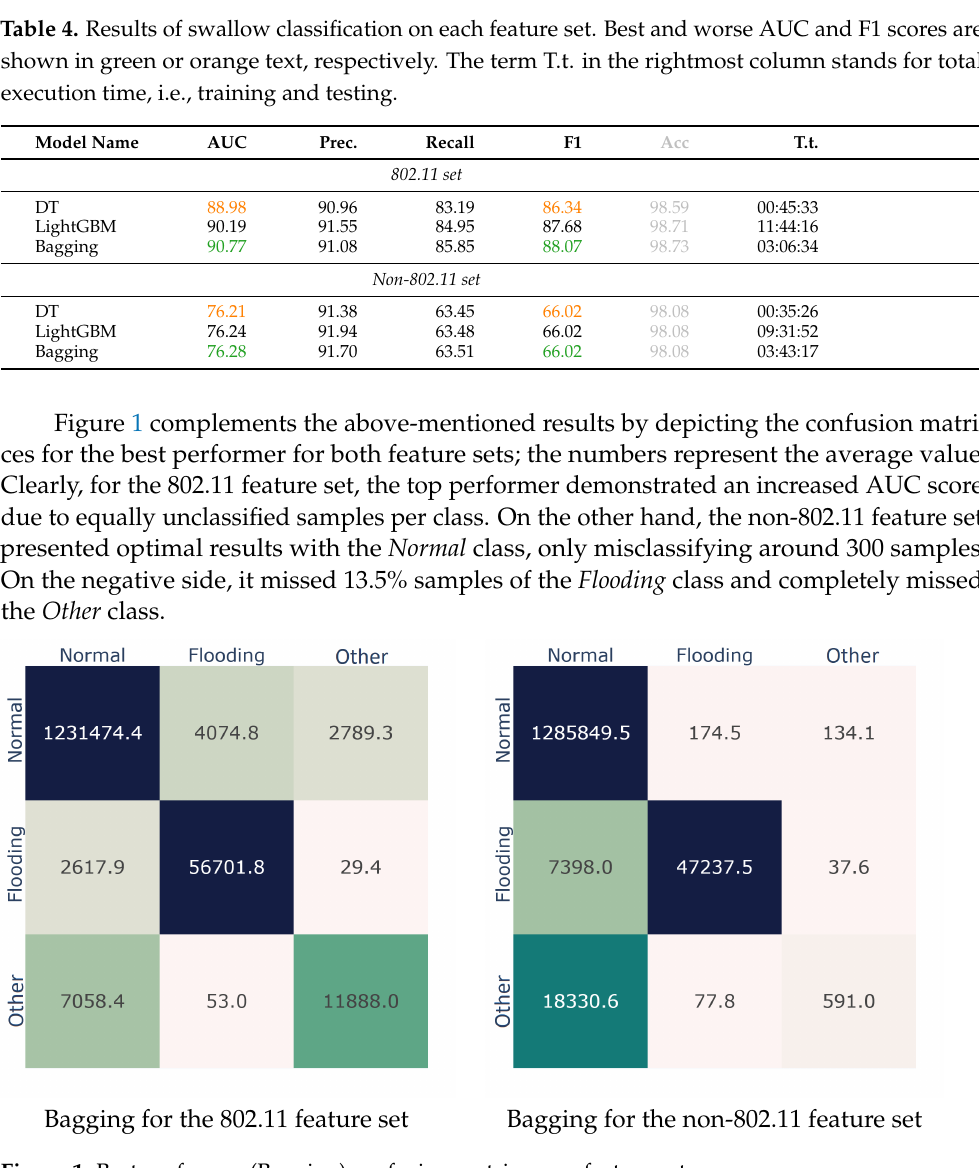
Figure 1. Best performer (Bagging) confusion matrices per feature